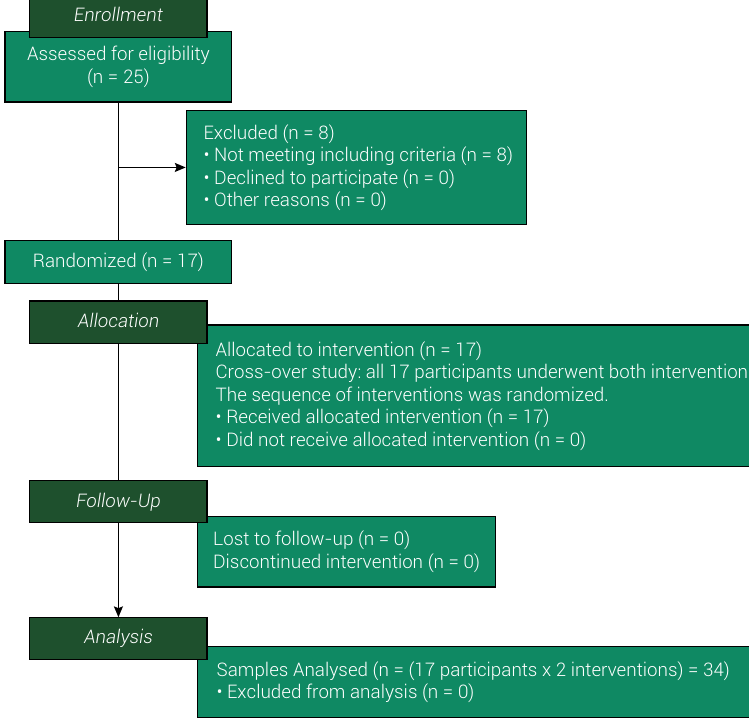
Figure 1. CONSORT 2010 Flow